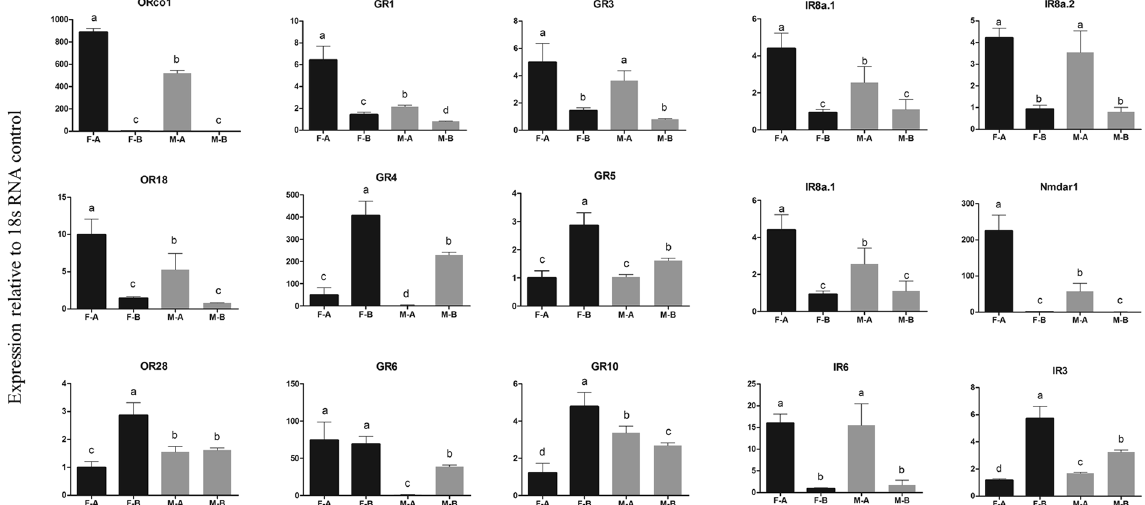
Figure 7. The tissue-specific transcript abundances of Aphidius gifuensis chemosensory receptor genes. FA: female antennae, MA: male antennae, FB: female body, MB: male body. Each bar graph in Fig. 7 represent a relative expression patterns of a chemoreceptor gene individually without any comparisons across panel. The error bars represents standard errors and the small letters above each bar indicate significant differences in transcript abundances ( p < 0.05).